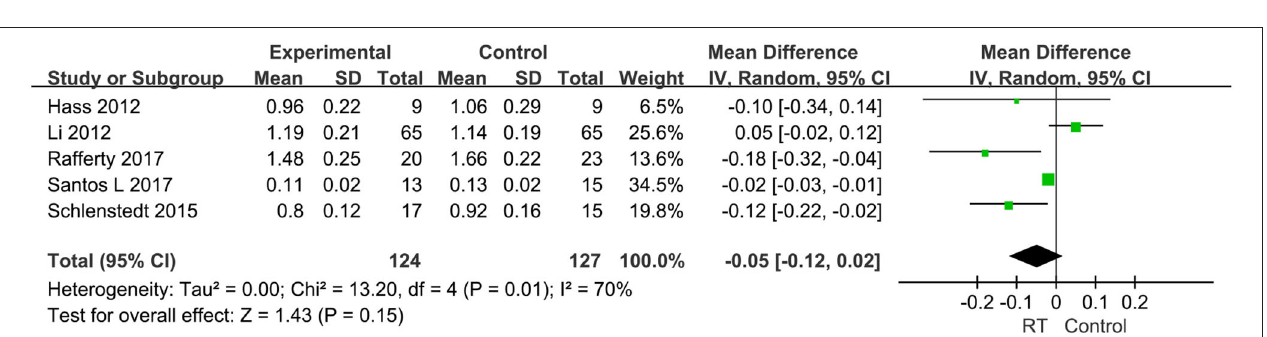
Frontiers in Neurology |